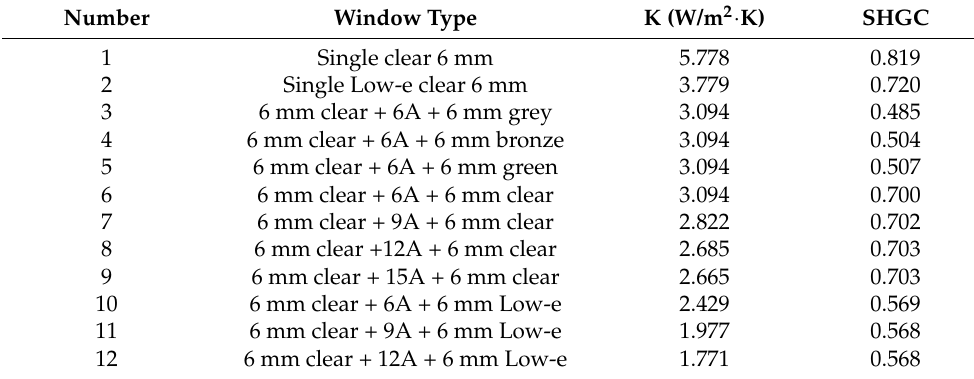
Table 6. External window types and